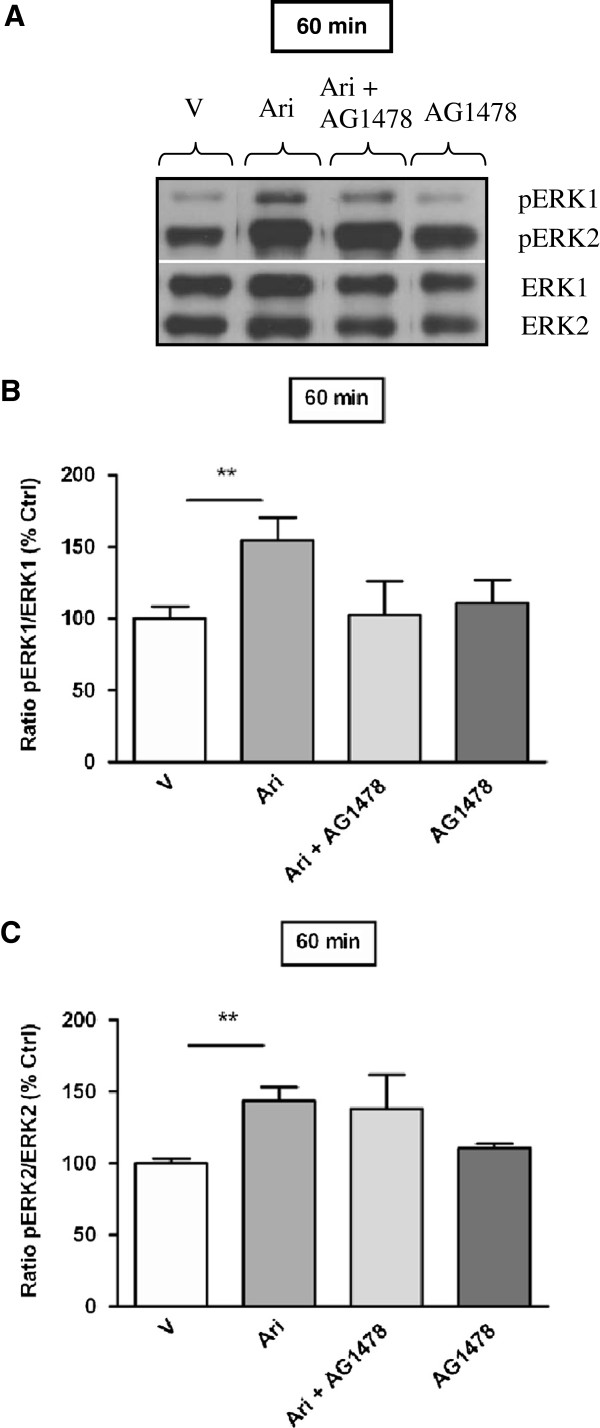
Effect of aripiprazole on ERK phosphorylation in C57Bl/6 mouse prefrontal cortex in the absence or presence of AG1478 (EGF receptor inhibitor). Representative blots (A) indicate immunoreactive bands of phosphorylated ERK1 and phosphorylated ERK2 (upper panel) and total ERK1 and total ERK2 (lower panel) levels following aripiprazole (1 mg/kg) ± AG1478 treatment and correspond with the bar graphs below. (B) Effect of AG1478 on aripiprazole induced ERK1 phosphorylation at 60 min. (C) Effect of AG1478 on aripiprazole induced ERK2 phosphorylation at 60 min. Data are expressed relative to vehicle control standardized to 100 percent and represent the mean ± SEM of at least four mice per experimental group. **p < 0.01, statistical differences between tissue in the absence (V) and presence of aripiprazole are indicated. V = Vehicle, Ari = Aripiprazole.